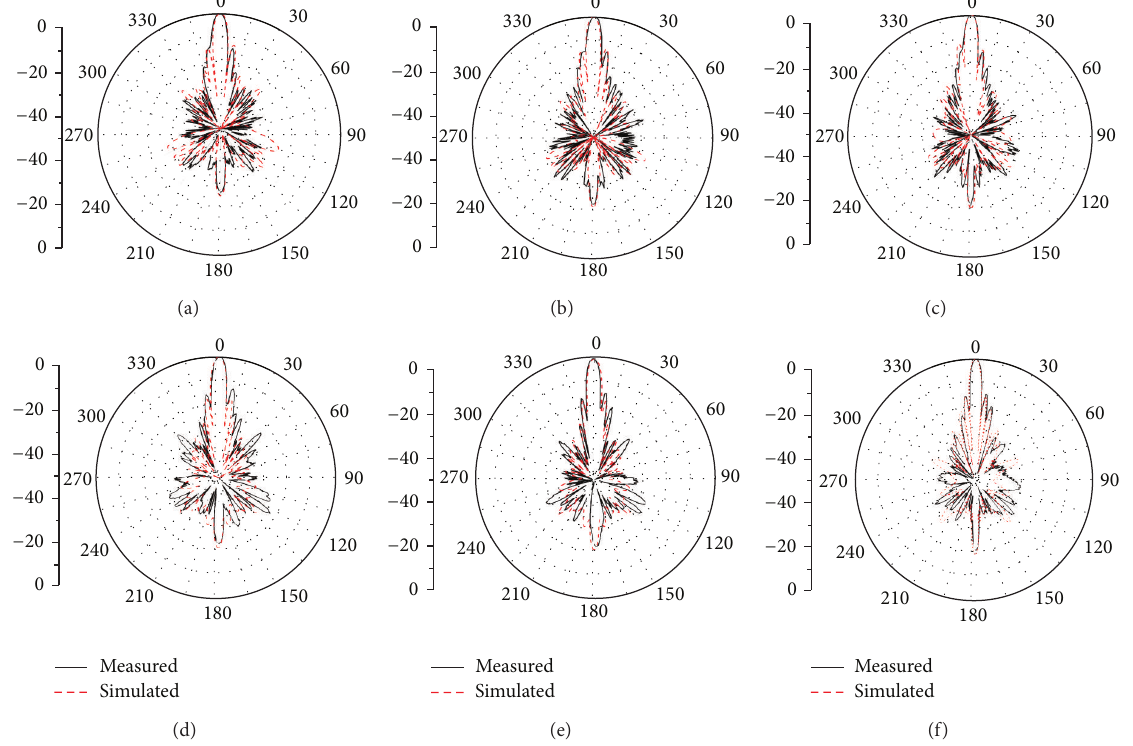
Figure 11: The measured far-field patterns at (a) 12.25 GHz, E plane (b) 12.5 GHz, E plane (c) 12.75 GHz, E plane (d) 12.25 GHz, H plane (e) 12.5 GHz, H plane (f) 12.75 GHz, H